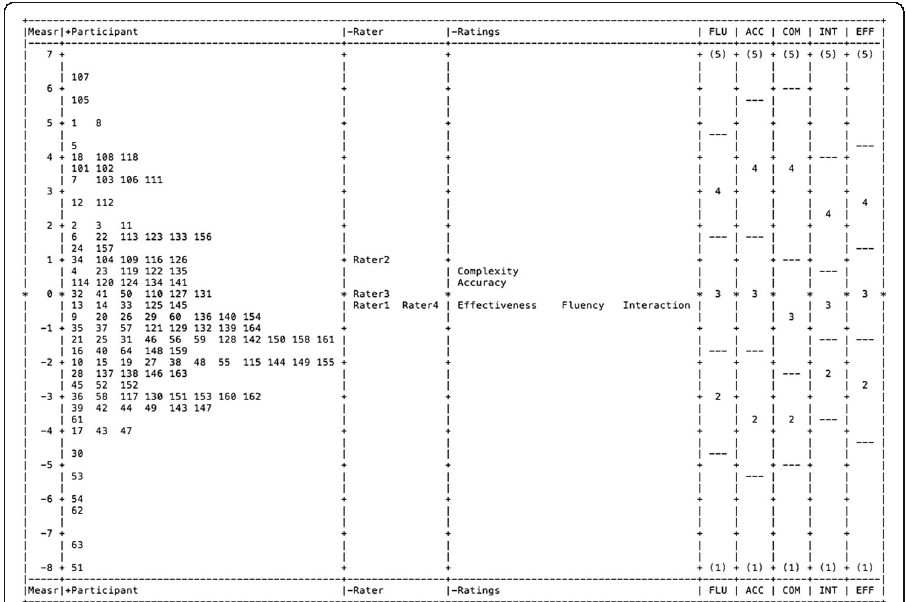
Fig. 3 The variable map of the MFRM analysis of the revised 5-point rating scales. FLU = Fluency, ACC = Accuracy, COM = Complexity, INT = Interaction, and EFF = Communicative